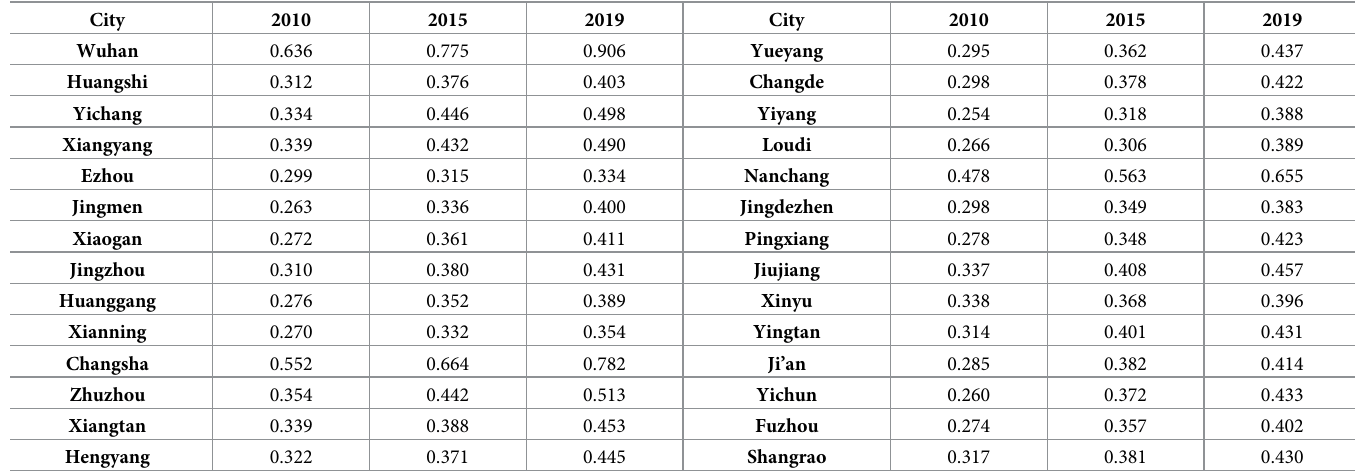
Table 5. The coupling coordination degree between economic resilience and high-quality economic development in the UAMRYR from 2010–2019. City